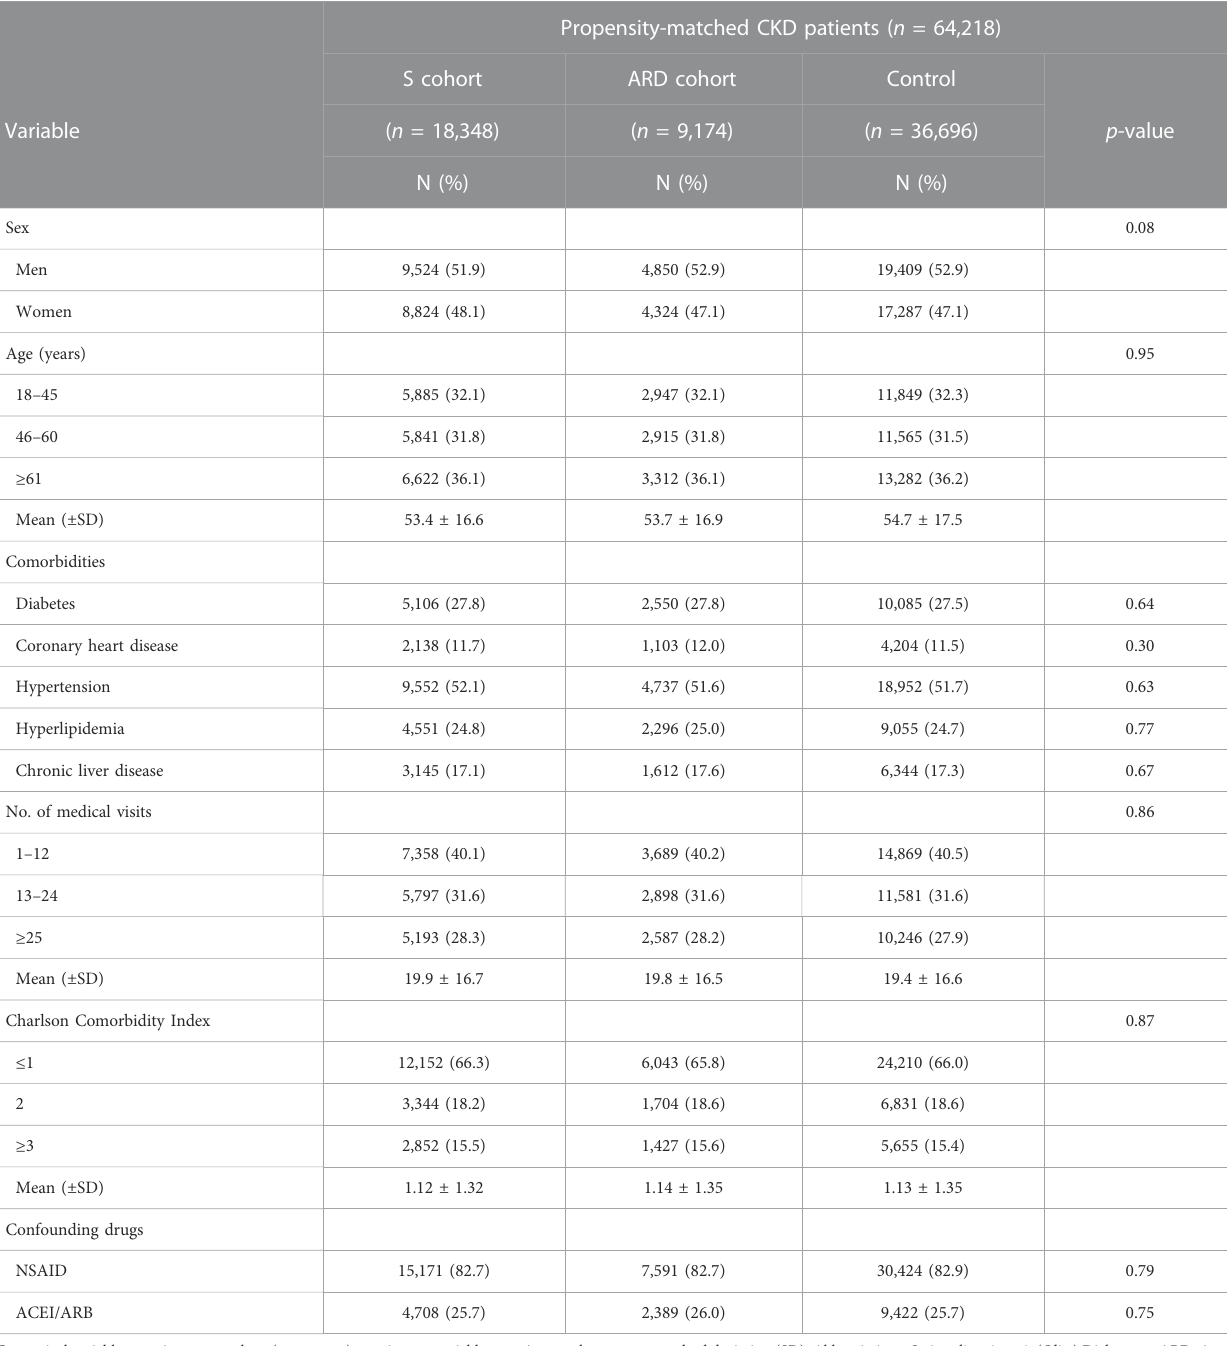
TABLE 1 Baseline characteristics of the three study cohorts in CKD